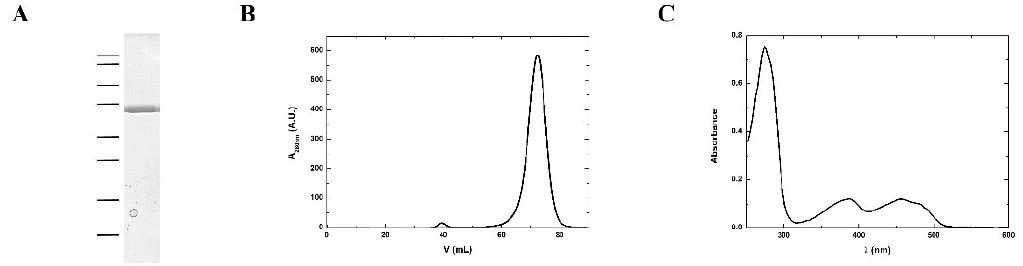
Figure 2. MmNTR was heterologously expressed in E. coli , and purified by affinity and size exclusion chromatography. ( A ) A Coomasie-stained SDS-PAGE image of purified MmNTR. The molecular weight markers are indicated on the left (100, 75, 50, 37, 25, 20, 15, and 10 kDa); ( B ) The size exclusion chromatography (Sephacryl S300) elution profile for MmNTR; ( C ) The UV-visible absorption spectrum of MmNTR in buffer, 10 mM Tris-HCl pH 7.6, 100 mM NaCl, and 2 mM 2-mercaptoethanol.